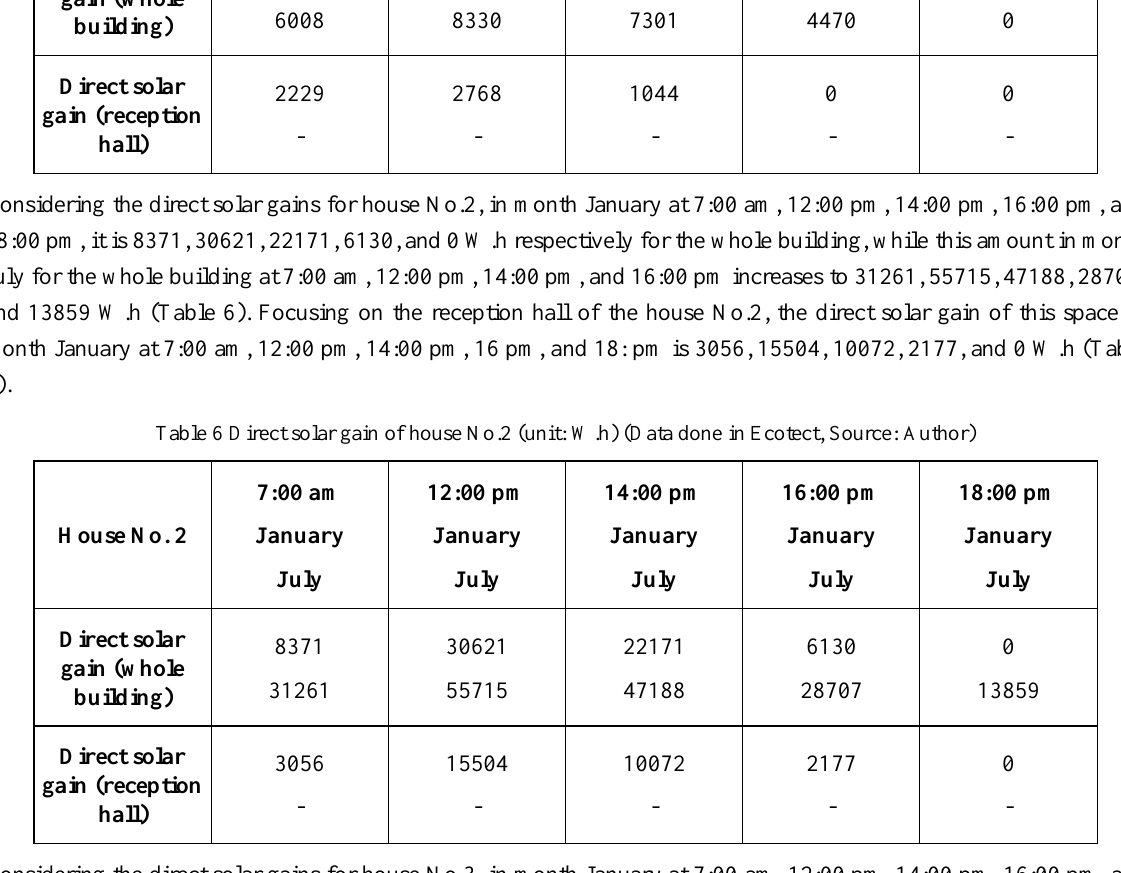
Table 7 Direct solar gain of house No.3 (unit: W.h) (Data done in Ecotect, Source: Author)